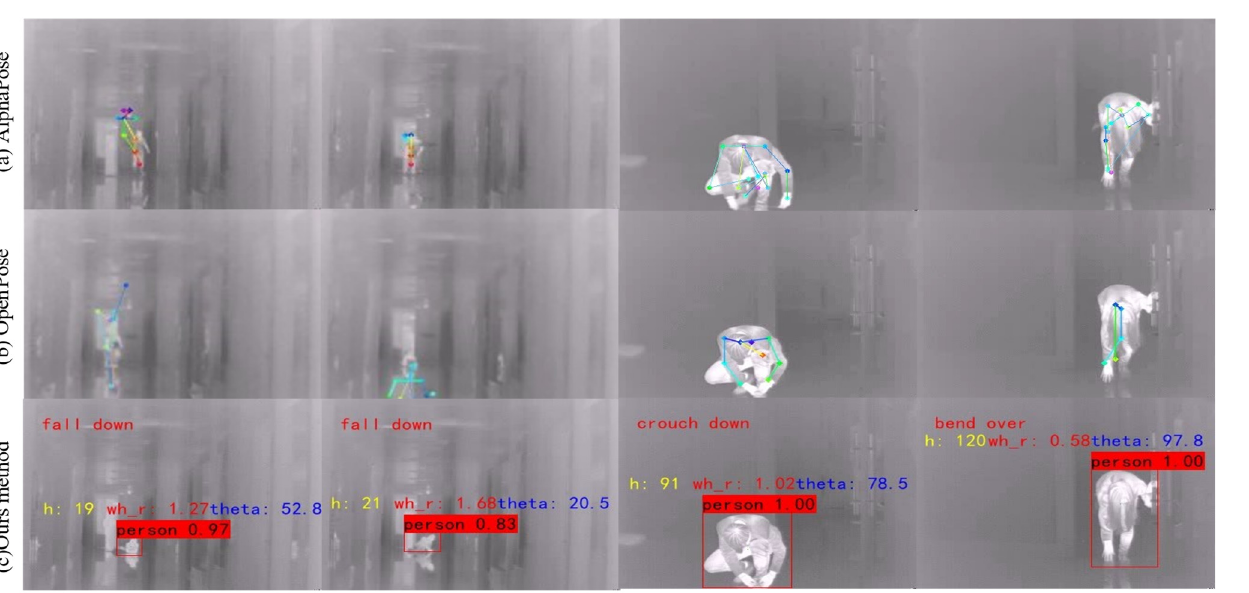
Figure 11. Comparison of results. ( a , b ) show that the extracted skeletal keypoints of AlphaPose and OpenPose in both scenes are not guaranteed to be accurate. Therefore, we can imagine the difficulty of the skeletal keypoint-based method for behavior recognition in this scene. Furthermore, ( c ) demonstrates that the method in this paper can still effectively extract the features required for the BPF (h is height, wh_r is the aspect ratio, and theta is orientation angle in ( c )) and successfully detect the falling